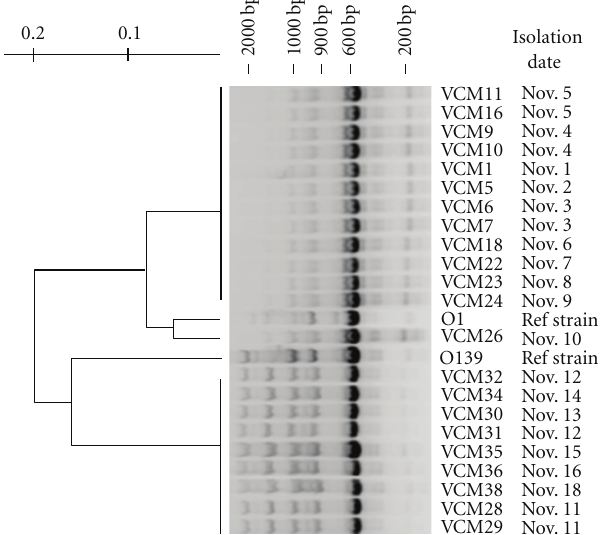
Figure 3: Cluster analysis of ERIC-PCR fingerprints of V. cholerae isolates in November 2005. Isolates were grouped into two clusters, Genotype1: VCM1–VCM24; and Genotype2 VCM28–VCM38, that were separated by the date of isolation. V. cholerae O1 (ATCC 14033) and O139 (NICED) were used as references